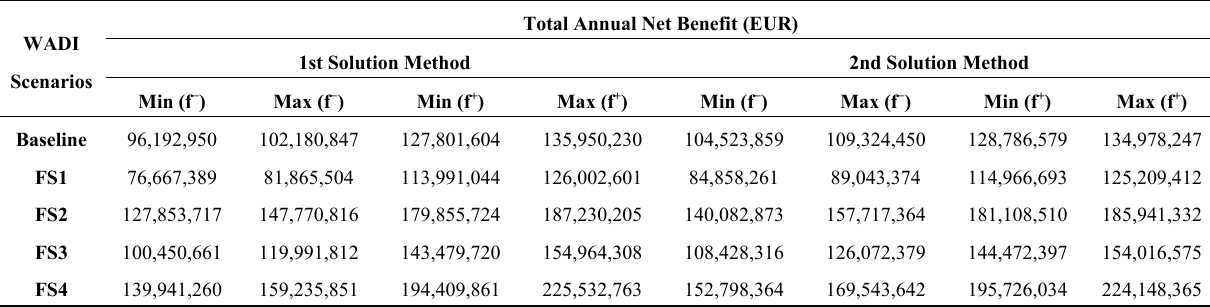
Table 8. Total annual net benefit (EUR) for all water